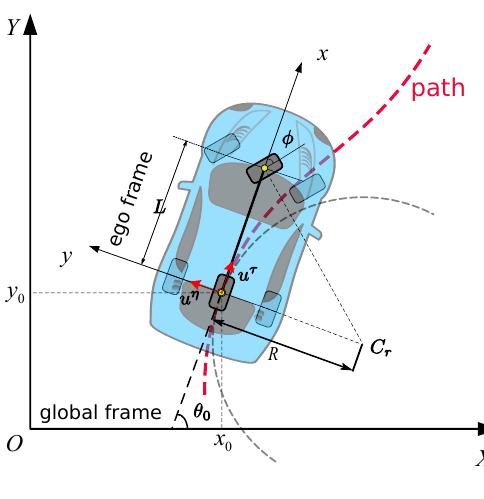
Figure 2. Single track car